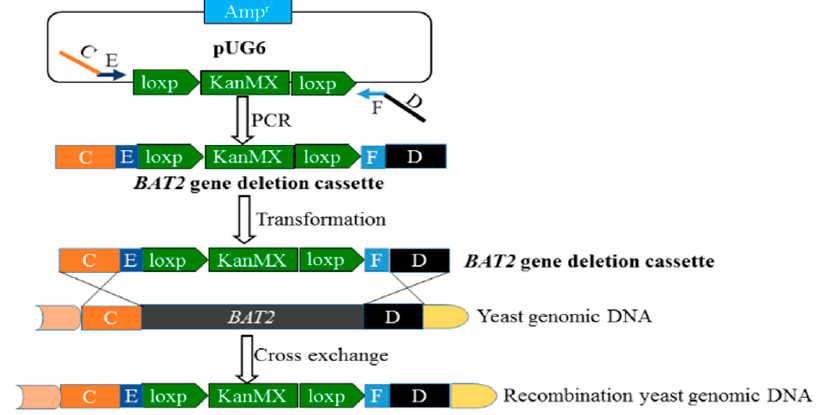
Figure 1. Construction scheme of the BAT2 deletion cassette using LPSHR.